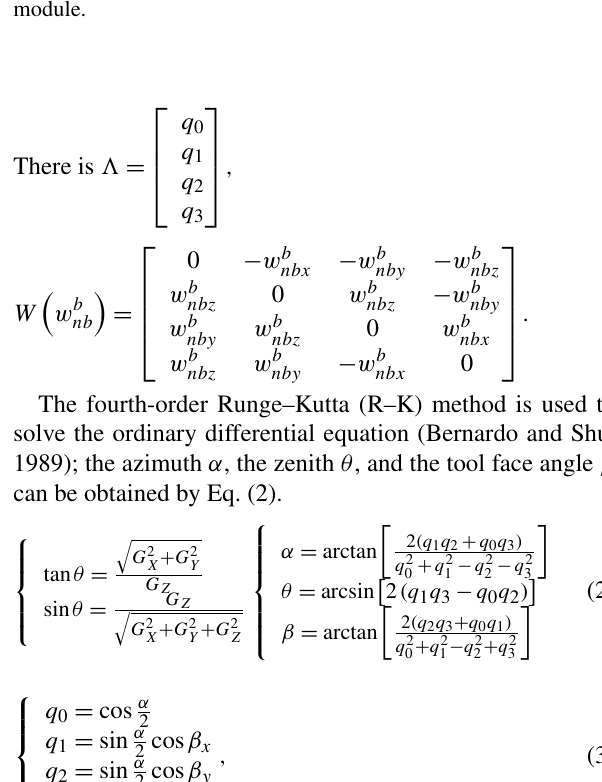
Figure 5. Composition diagram of the three-axis measurement